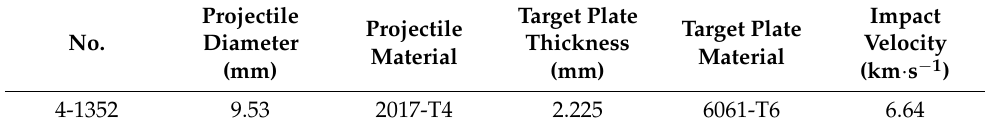
Table 2. Control test parameters.